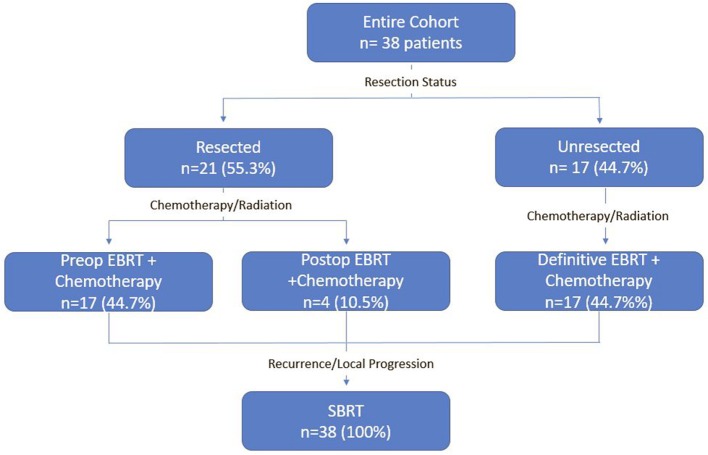
Treatment scheme.